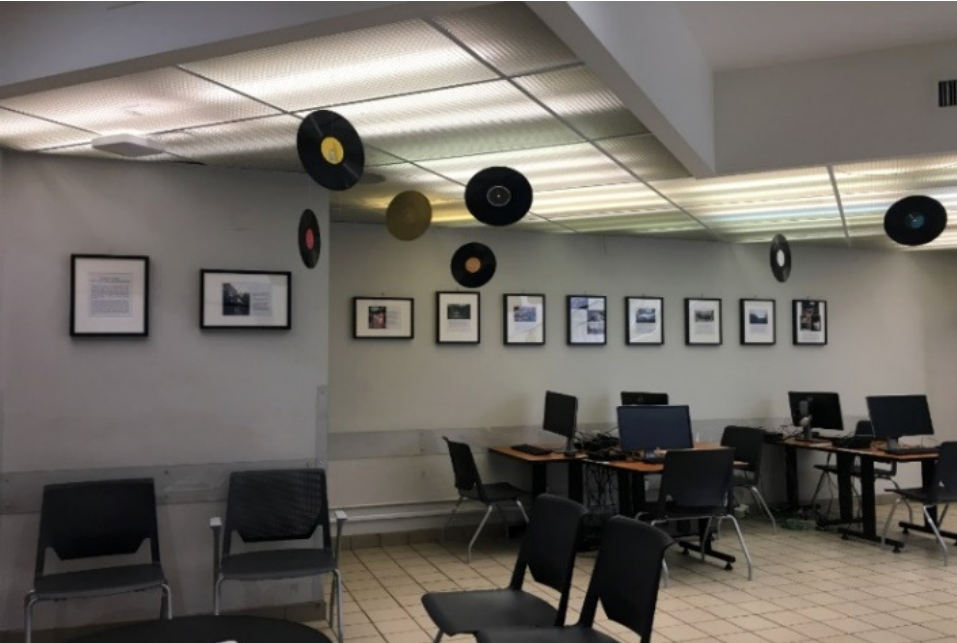
Figure 2. Community exhibition at the University of British Columbia Learning Exchange, Downtown